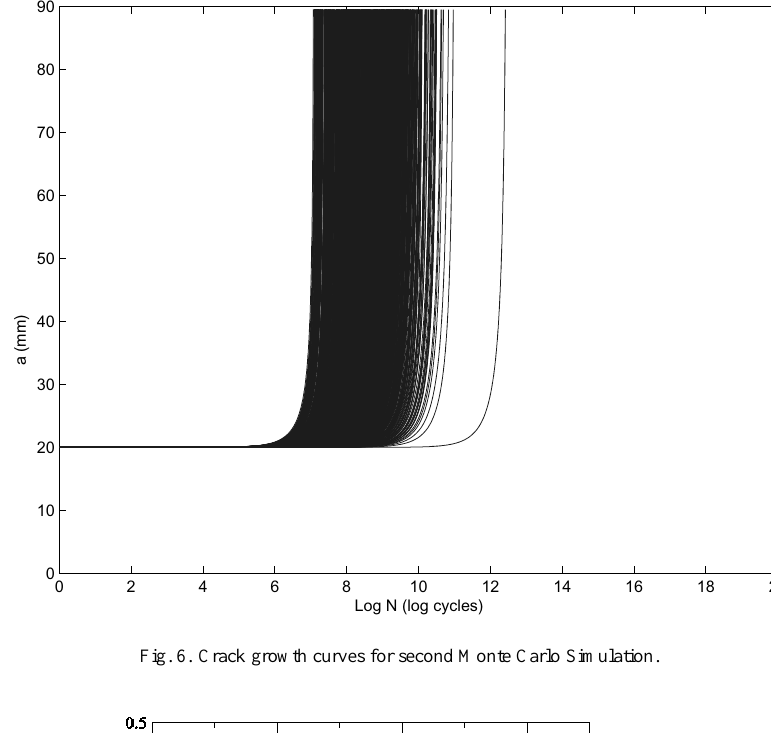
Fig. 6. Crack growth curves for second Monte Carlo Simulation.